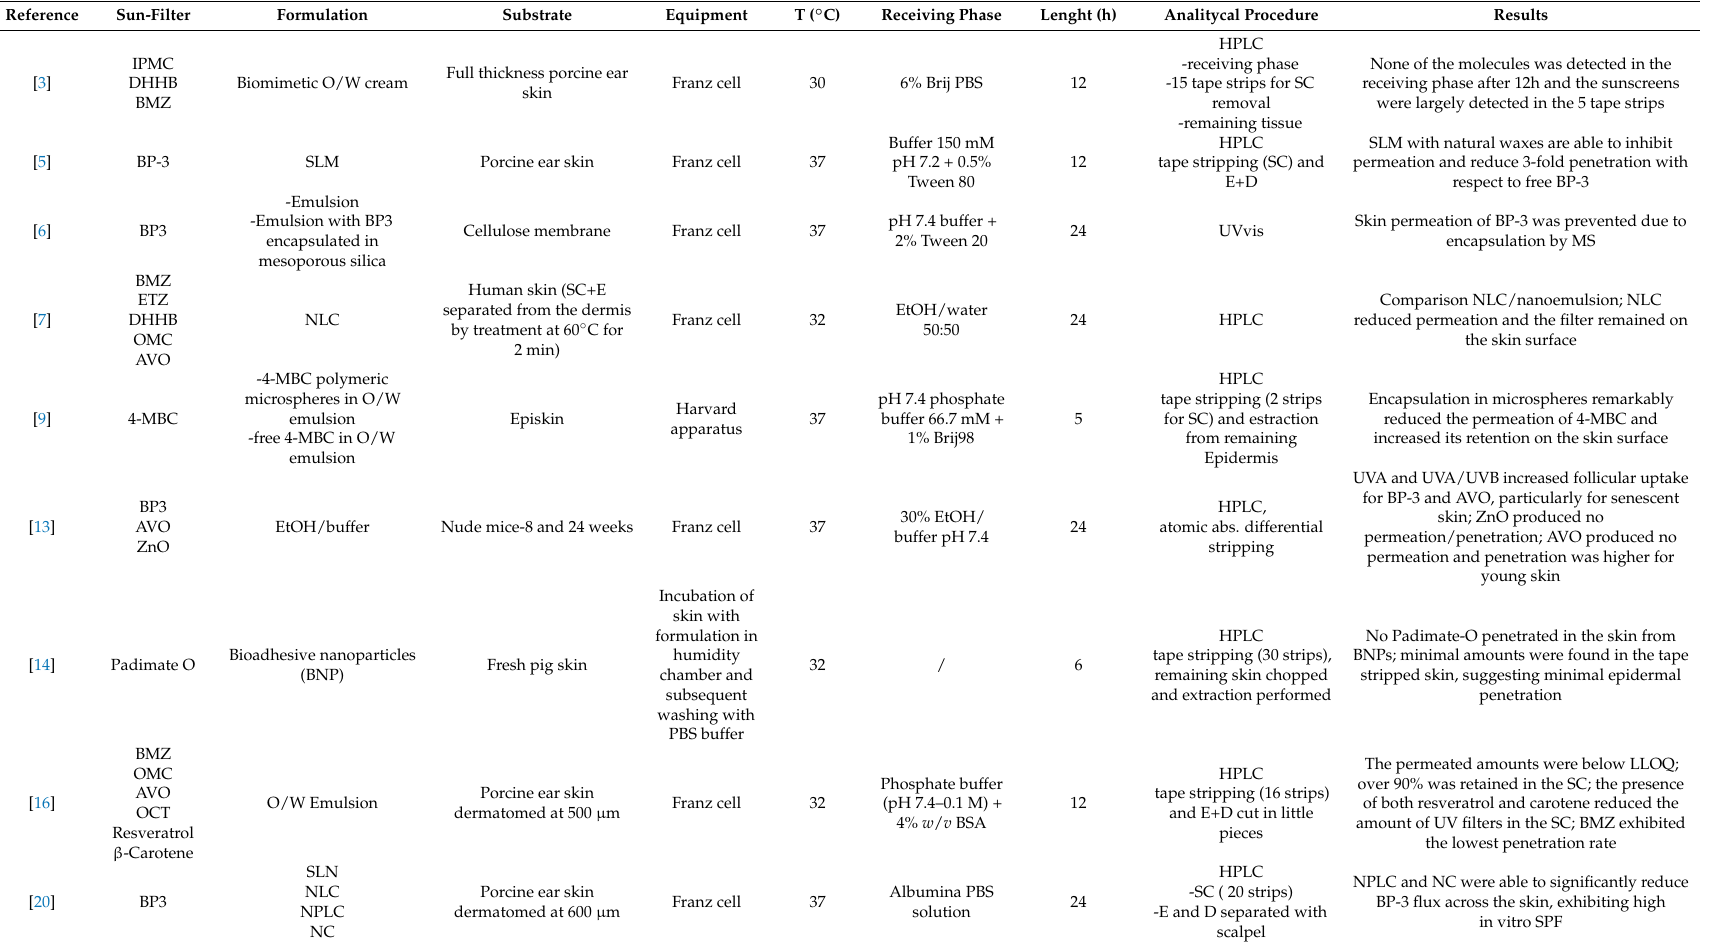
Table 2. In vitro studies for the assessment of skin permeation/penetration of